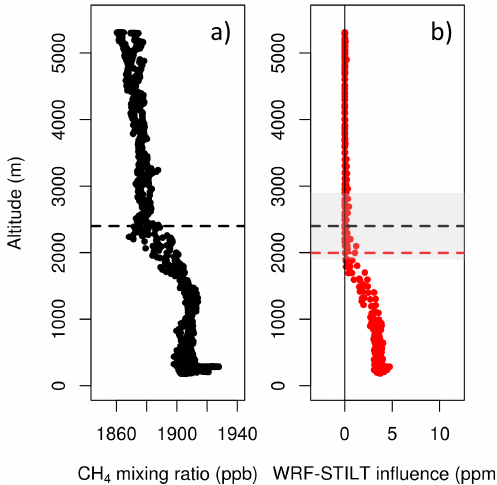
Figure 18. Vertical profiles near Fairbanks, AK, on 21 August 2012 of (a) methane mixing ratio based on observations from the CARVE aircraft (in black), and (b) enhancements to the methane mixing ra- tio based on an aggregation of 370 WRF-STILT footprints (in red). Dashed black line at approximately 2400m in each panel represents the top of the atmospheric column enhancement as determined us- ing observations from panel (a) . Red dashed line in panel (b) at approximately 2000m denotes the top of the atmospheric column enhancement as defined by